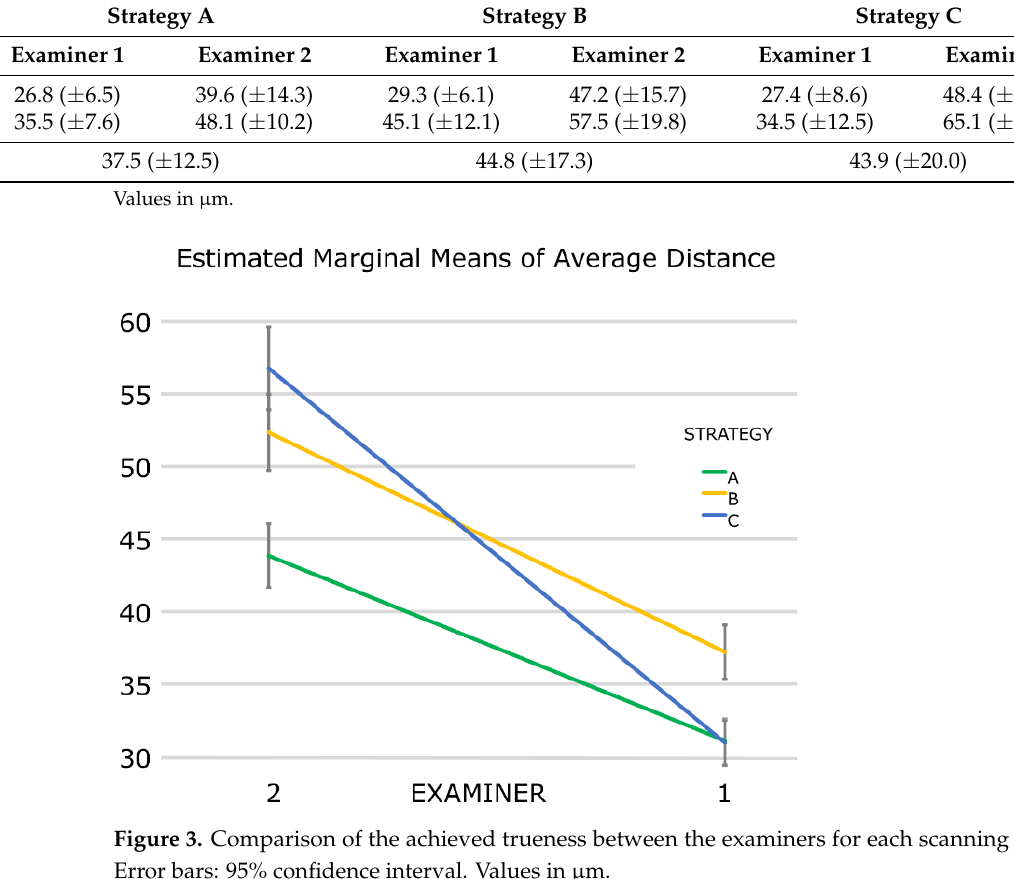
Table 2. Results of the trueness study of the IOS. Mean and standard deviation for each scanning strategy, examiner, and session.